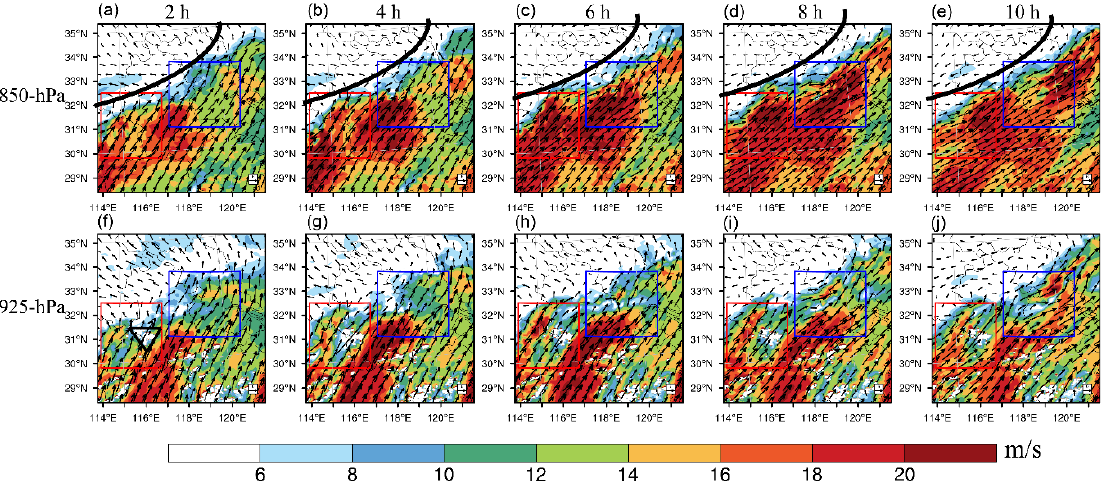
Figure 2. The 850-hPa horizontal wind vectors and wind speed (color) from TRUE, (a) 14:00 UTC, (b ) Figure 2. The 850 hPa horizontal wind vectors and wind speed (color) from TRUE, ( a ) 14:00 UTC, 16:00 UTC, (c) 18:00 UTC, (d) 20:00 UTC, (e) 22:00 UTC; 925-hPa horizontal wind vectors and wind ( b ) 16:00 UTC, ( c ) 18:00 UTC, ( d ) 20:00 UTC, ( e ) 22:00 UTC; 925 hPa horizontal wind vectors and wind speed (color) from TRUE, (f) 14:00 UTC, (g) 16:00 UTC, (h) 18:00 UTC, (i) 20:00 UTC, (j) 22:00 UTC. speed (color) from TRUE, ( f ) 14:00 UTC, ( g ) 16:00 UTC, ( h ) 18:00 UTC, ( i ) 20:00 UTC, ( j ) 22:00 UTC. The The black curves indicate the Meiyu-front. The black tangle in (f) marks out the main peak (>600 m black curves indicate the Meiyu-front. The black tangle in ( f ) marks out the main peak ( > 600 m height) height) of the Dabie Mountains. of the Dabie